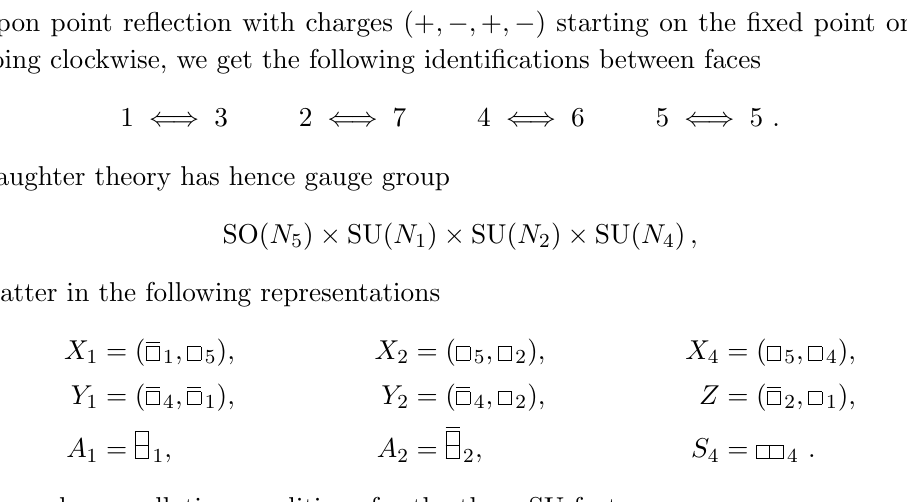
Figure 5 . PdP 4 dimer. Red crosses represent (cid:12)xed points under the orientifold action. This is related to an important qualitative di(cid:11)erence with respect to the previous example. In this model there exist deformation fractional branes, together with N = 2 ones. For instance, the strip 1-3-5 is a N = 2 brane, while 2-6 and 1-2-5 are two di(cid:11)erent kinds of deformation